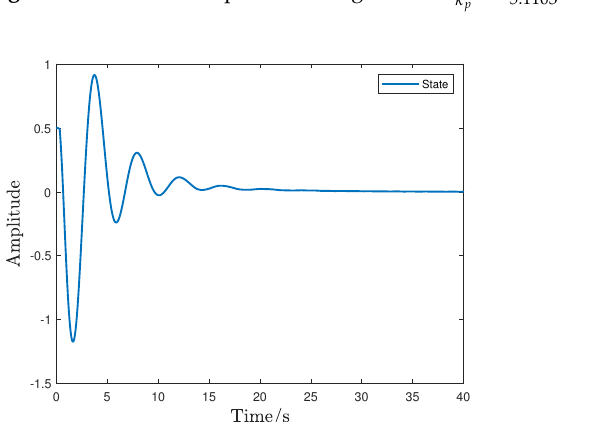
Figure 10. Feasible PID parameter region with k i